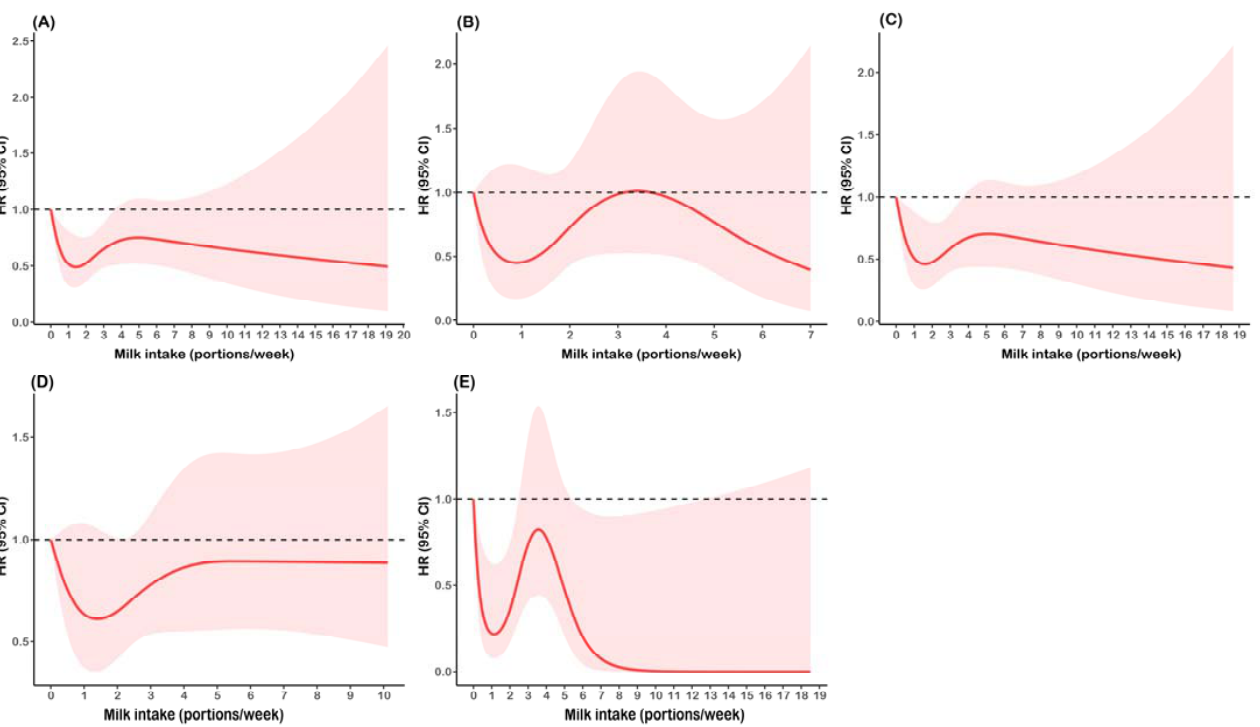
Figure 2. Restricted cubic spline plots to evaluate relationships between milk intake and all-cause mortality among ( A ) Overall participants; ( B ) Participants with low dietary diversity score; ( C ) Participants with high dietary diversity; ( D ) Participants with low energy intake; and ( E ) Participants with high energy intake. HR and 95% CI were adjusted for age, sex, education, place of residence, individual annual income, smoking status, alcohol intake, physical activity, BMI, chronic disease history, vegetable intake, fruit intake, red meat intake , dietary diversity score, and energy intake. Dietary diversity score and energy intake were not adjusted in their corresponding stratified analyses. Units of milk intake: portions/week (1 portion = 300 g).